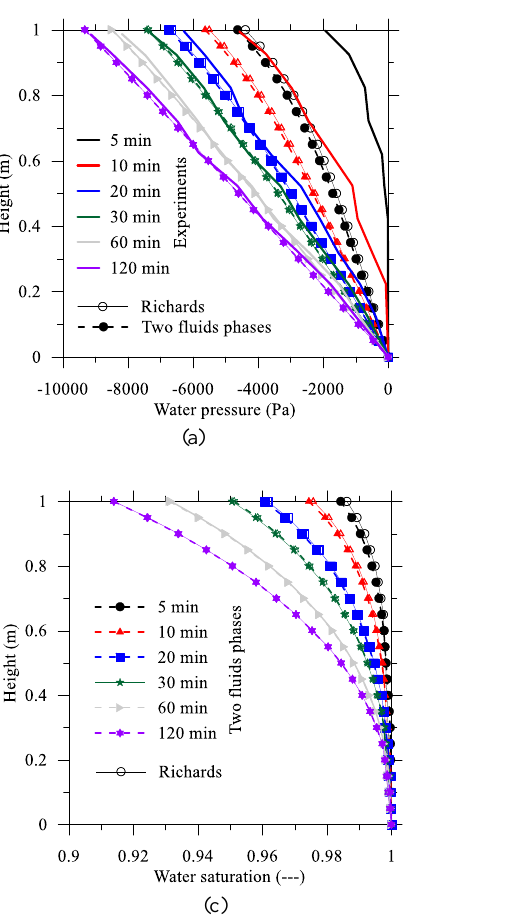
Figure 6. Finite element results and Liakopoulos experiments: ( a ) water pressure, ( b ) outflow rate, ( c ) water saturation, and ( d ) vertical displacement. Figure 5. Liakopoulos test arrangement ( a ) 𝑡 = 0 − , and ( b ) 𝑡 = 0 + (Note: not in scale).